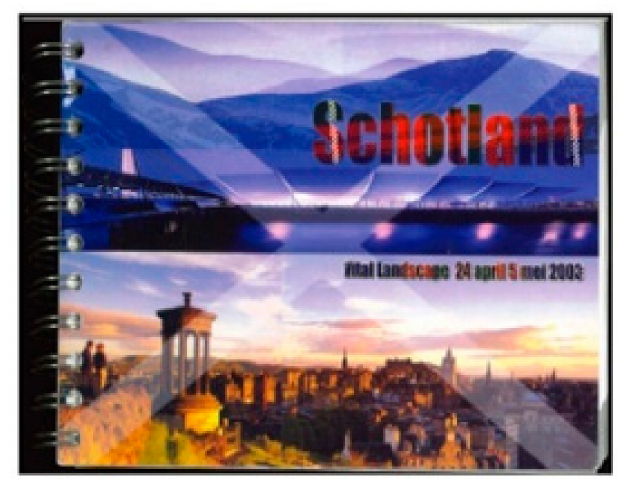
Figure 18. Excursion guide for town planning students Delft to Scotland in 2003 [53].